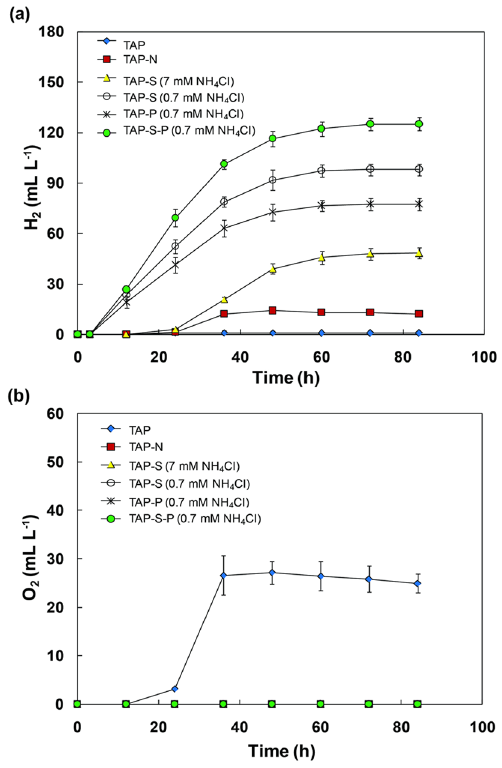
Fig. 1. H photoproduction and O evolution of C. 2 2 sorokiniana cells pre-cultured under TAP or nitrogen limited medium and then grown under sulfur, nitrogen or phosphorus deprivation. Volume of H yield detected 2 in six treatments with pronounced H production (TAP, 2 TAP-N, TAP-S (7 mM NH Cl), TAP-S (0.7 mM NH Cl), TAP-P 4 4 (0.7 mM NH Cl), TAP-S-P (0.7 mM NH Cl)) (a), volume of 4 4 O evolution in TAP cultures (b). All points are the mean 2 of three independent